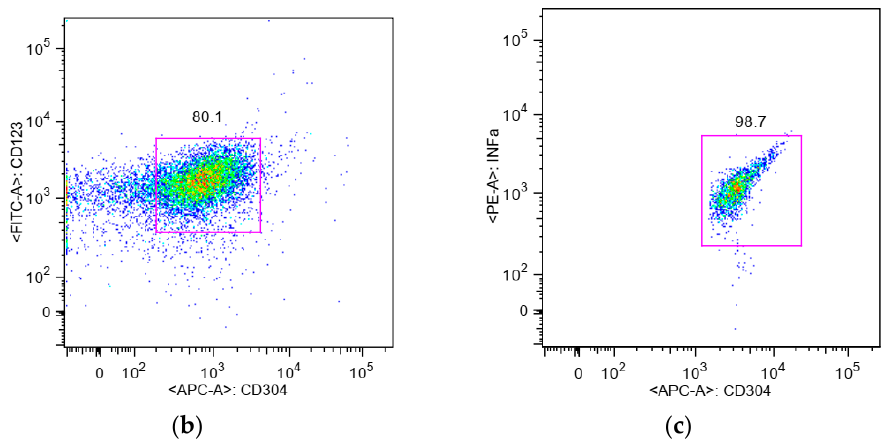
Figure 4. The IFN α secretion by pDCs in the co-cultures with MM cells: ( a ) Proliferation of MM cell lines including U266, KMS-11, OPM-2 and LP-1 (5 × 10 5 cells/1 mL) alone (white bars) and in the presence of freshly sorted pDCs (10 5 cells/1 mL) at a 5:1 ratio for 24 h (grey bars) co-cultured in 24-well plates was analyzed. Numbers of IFN α producing pDCs are shown (black bars). Stimulation of pDCs alone with PMA and CI is shown (pale grey bars). Data are shown as mean ± SD from three independent experiments. Significant differences in pDC co-cultures were determined using the unpaired t test as * p < 0.01 (KMS-11, LP-1), ** p = 0.001 (U266) and *** p = 0.0005 (OPM-2) respectively. ( b ) Representative FACS plot analysis of pDC populations identified as CD123 and CD304 by surface staining. ( c ) Intracelllular staining showing pDC positive populations secreting IFN α .